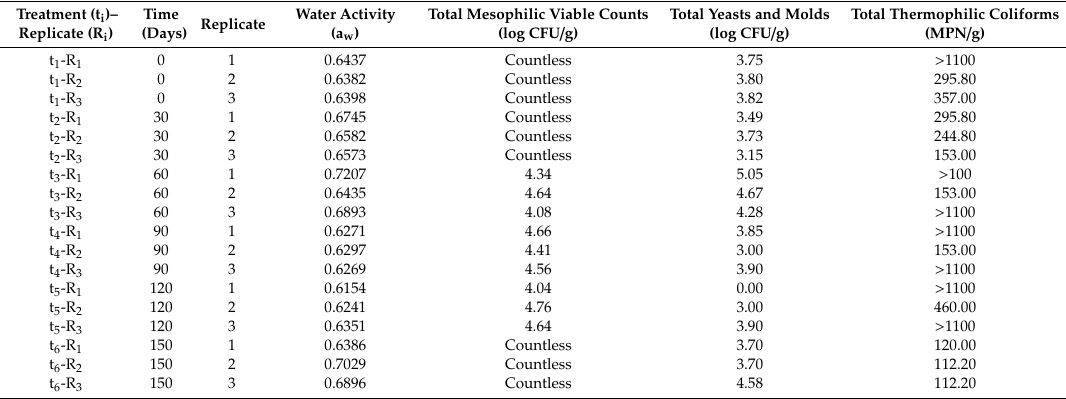
Table 4. Observation values for 3 replicates (R) of the water activity (a w ), decimal logarithm of total viable mesophilic and yeast and mold counts (colony-forming units) per gram of sample (CFU / g), and most probable number (MPN) of total thermophilic counts per gram (MPN / g) of sample throughout 150 days of storage of cupuaçu beans with seed